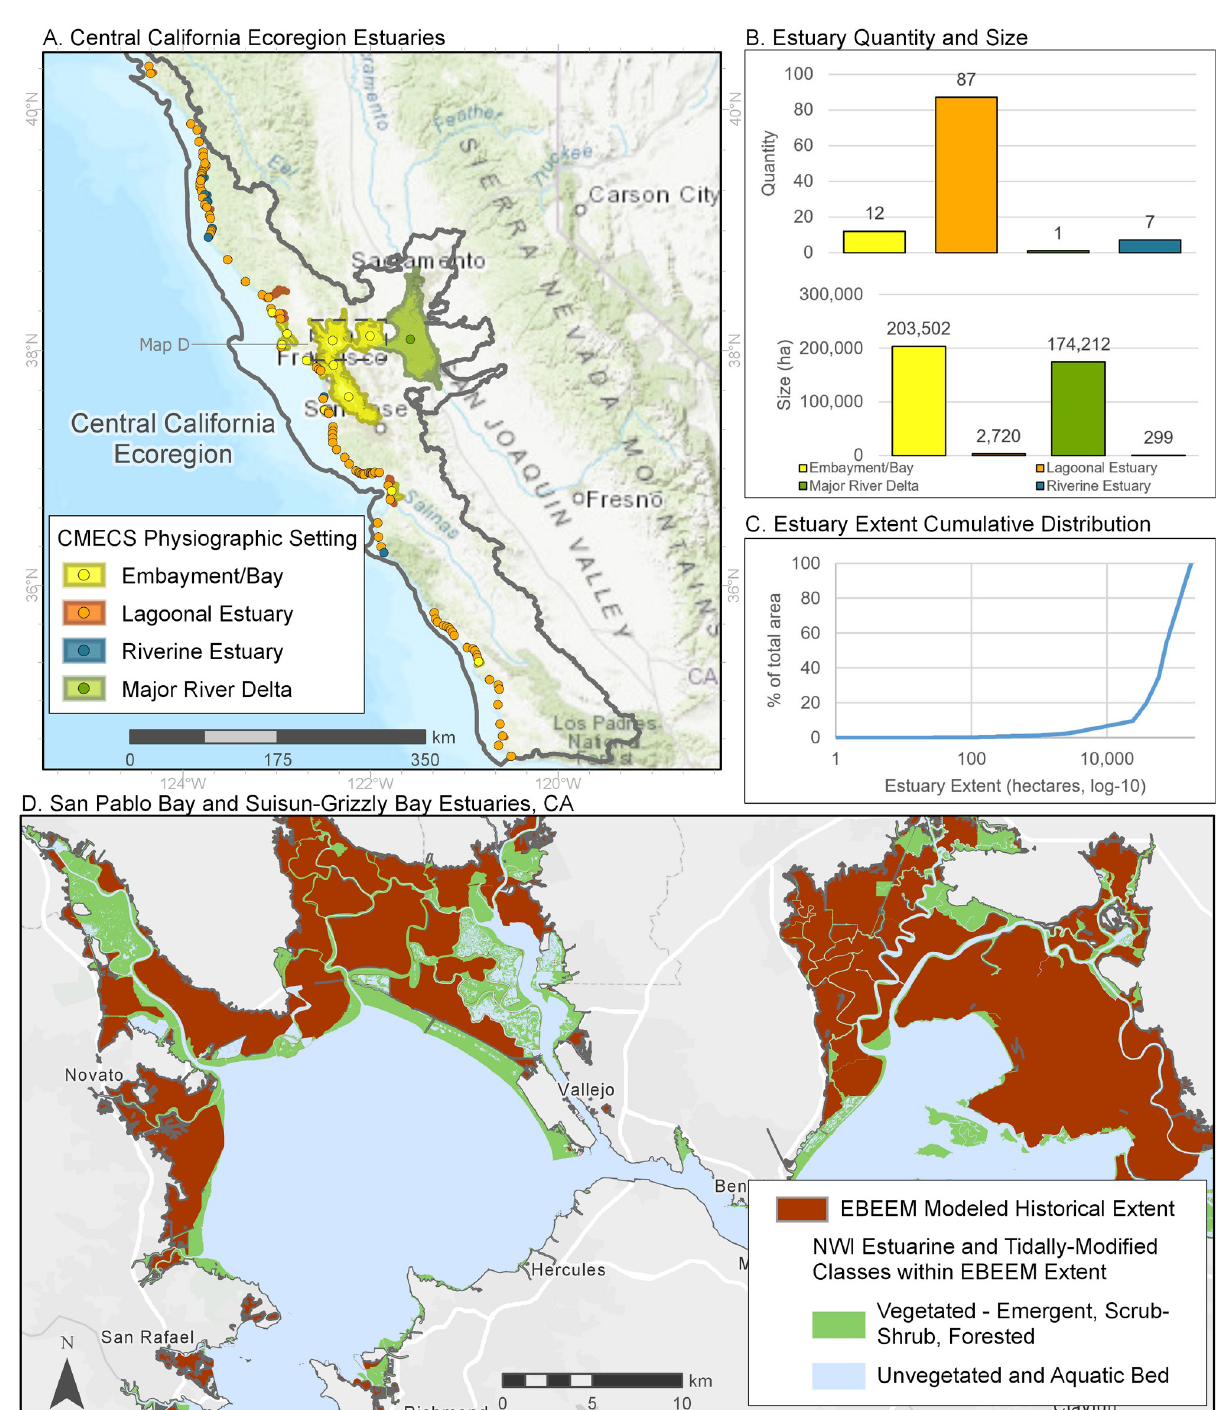
Fig 9. Summary of estuaries in the Central California ecoregion of the Pacific Coast. See Fig 7 for details.